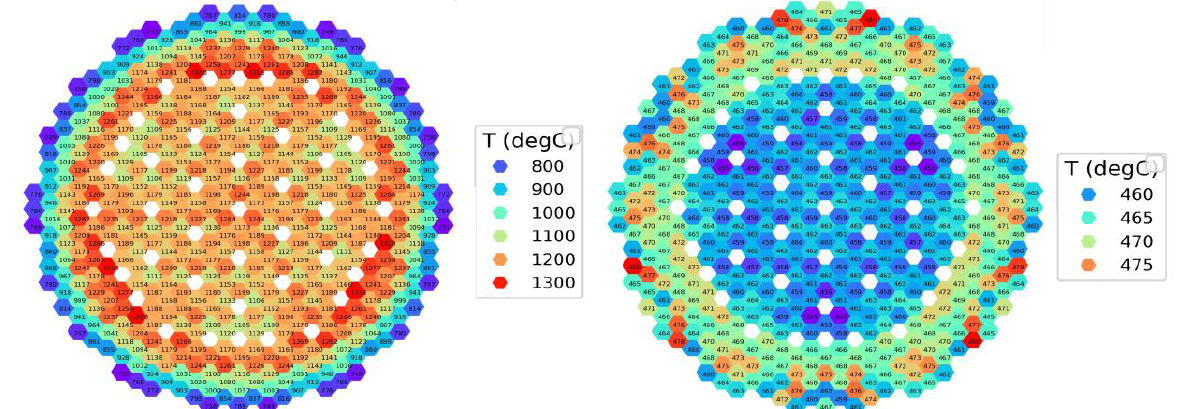
Figure 4. Fuel (left) and coolant (right) temperature distribution (K) at EOEC for ESFR-SMART core, calculated using WIMS with thermal